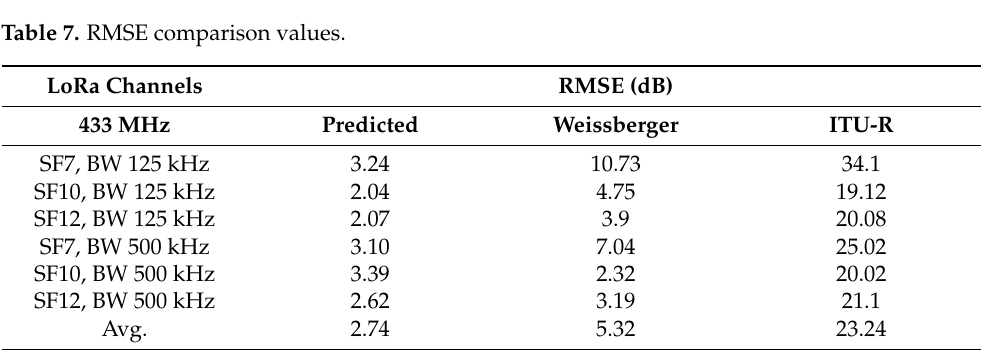
Table 7. RMSE comparison